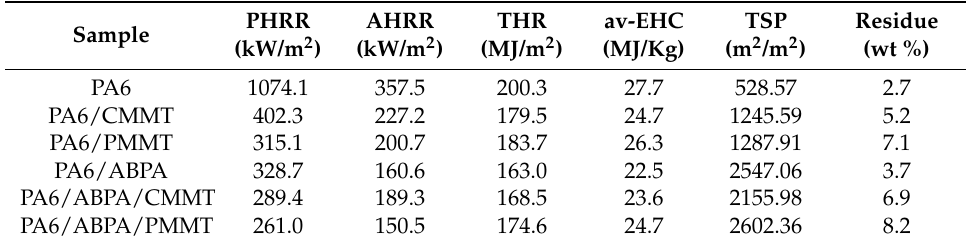
Table 5. Cone calorimetric results of PA6 and PA6